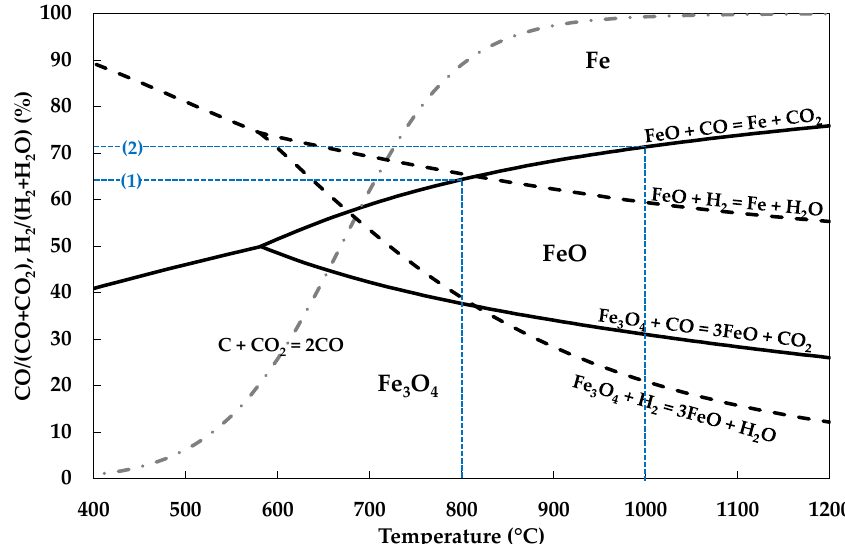
Figure 2. Baur-Glaessner diagram, Fe-O-C (full) and Fe-O-H (dotted) equilibrium curves with superimposed Boudard curve, based on thermodynamic data from HSC Chemistry version 8.2. [34] Lines (1) and (2) show % CO/(CO + CO 2 ) at equilibrium FeO + CO = Fe + CO 2 for 800 and 1000 °C.